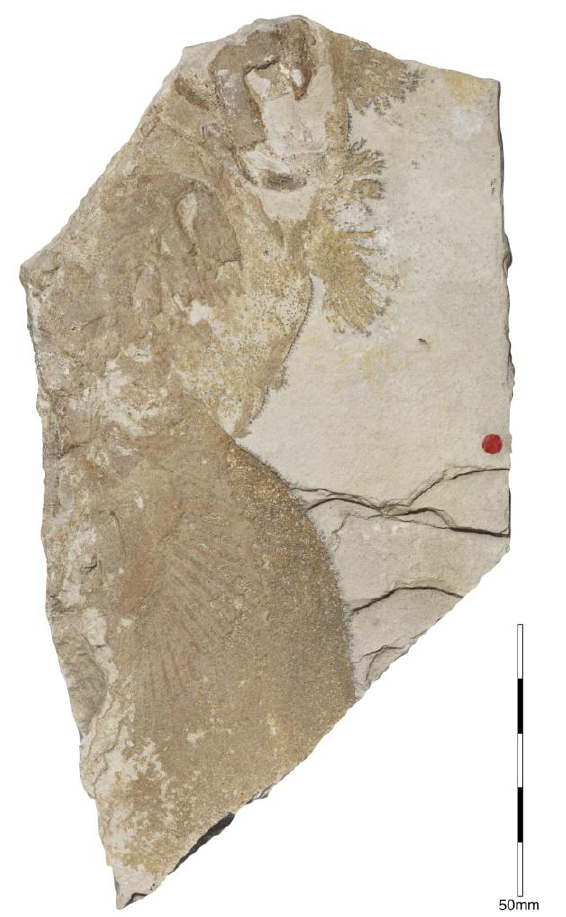
Figure 22. Holotype of the species † Palaeorectolobus agomphius Kriwet, 2008 [58] (MB.f. 11191) from the lower Tithonian of Kelheim.